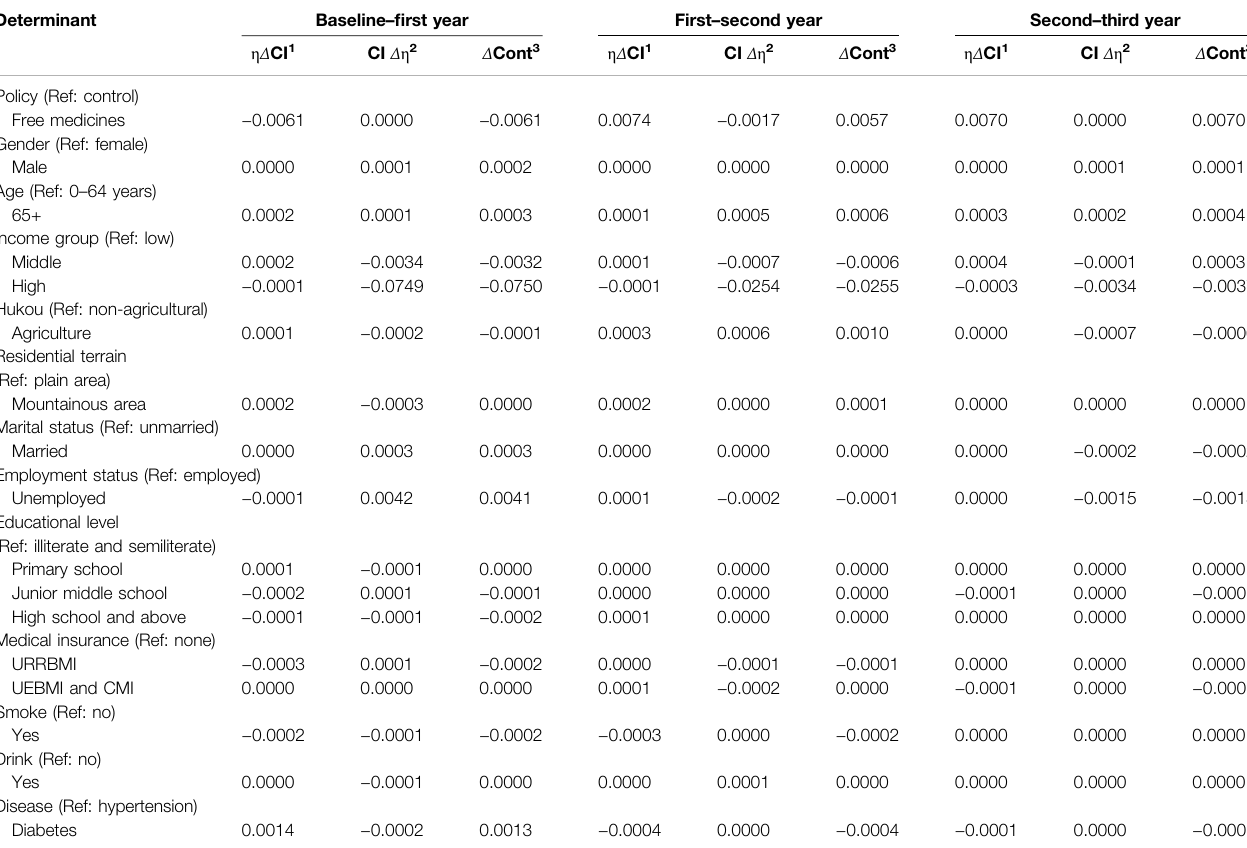
TABLE 4 | Oaxaca decomposition of CI in medication adherence over the 4 years.